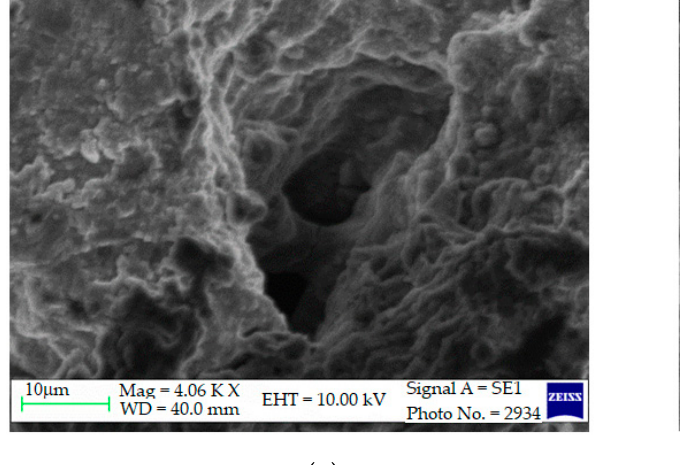
Figure 5. Micrographs attained by SEM with 1800× magnification for: ( a ) not calcined catalyst and ( b ) calcined catalyst. After calcination, the catalyst was used in the synthesis of biodiesel, aiming to eval- uate its performance during the oil transesterification reaction (Figure 6). Initially, a ki- netic study was carried out at 70 °C with oil: ethanol molar ratio of 1:12 in a reactor under